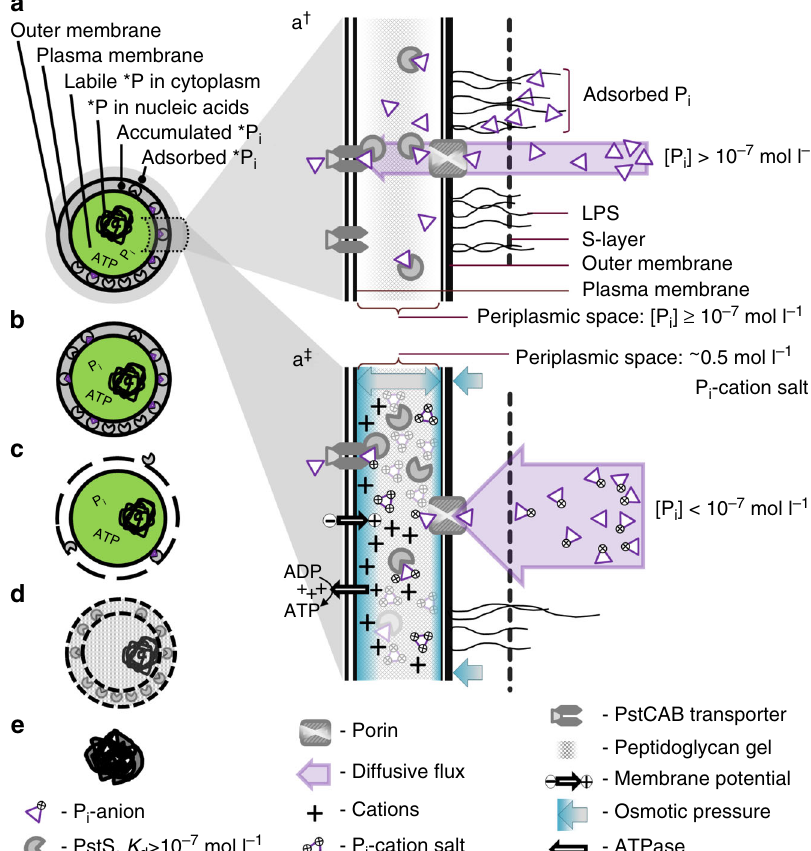
Fig. 1 Phosphate (P i ) acquisition by marine bacteria. a In a model cell labelled with *P i the *P i -tracer can be (i) extracellular, i.e., adsorbed onto the cell surface; (ii) accumulated in the periplasm; (iii) bound to the PstS subunit in the periplasm; (iv) in a labile form in the cytoplasm, e.g., soluble P i , nucleotides, sugar phosphates, small molecules of RNA; and (v) in a non-labile form of assimilated P, e.g., DNA, ribosomal RNA, polyphosphates, phospholipids. a † Current understanding — parallel processes of passive adsorption of P i to the bacterial cell surface composed of polymers of the outer membrane lipopolysaccharide (LPS) and overlaid (in some bacteria) by the proteinaceous surface layer (S-layer) and P i diffusion across the outer membrane through porins into the periplasm. Diffusion is coupled directly to P i transport across the cytoplasmic membrane by ABC-type transporters (PstCAB) using the periplasmic P i -binding protein (PstS). a ‡ The proposed model — mass transfer of P i anions across the outer membrane through porins, their buffering by cations of the membrane potential in the periplasm and import of P i from the buffered stock through the cytoplasmic membrane by PstCAB using P i -PstS. Isotonic or slightly hypertonic osmotic pressure is maintained in the periplasm by the buffered P i salt. b – e Removal of different phosphorus pools by washing or fi xation of a model *P i -labelled Synechococcus cell. b Treatment with surfactants, hydrolytic enzymes and amended ASW removes the extracellular P i adsorbed to cell surface constituents. c A short wash with hypotonic solution, e.g., deionized water (DW), dissolves the extracellularly adsorbed P i and, by causing osmotic shock, releases the periplasmic contents of a cell, i.e., the accumulated and PstS-bound P i . d Fixation of cells with paraformaldehyde (PFA) compromises the outer and inner membranes, releasing labile periplasmic and intracellular P i , but crosslinks cellular proteins, immobilizing the primary phosphorus-containing macromolecules including DNA, rRNA and P i -carrying PstS subunits. e Fixation of cells with trichloroacetic acid (TCA) disrupts membranes and precipitates cellular macromolecules (proteins, nucleic acids, polyphosphates and polysaccharides), thereby releasing labile P i but immobilizing most of the assimilated P i